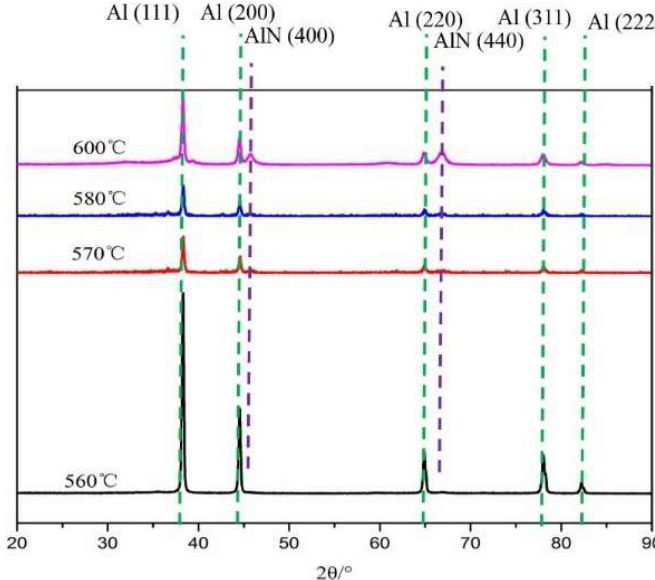
Figure 3. X-ray diffraction (XRD) patterns of the aluminum nanoparticles (ANs) after surface nitridation at different treatment temperature from bottom to top (black: 560 ° C ), (red: 570 ° C ), (blue: 580 ° C ), and (rose: 600 ° C ) respectively.